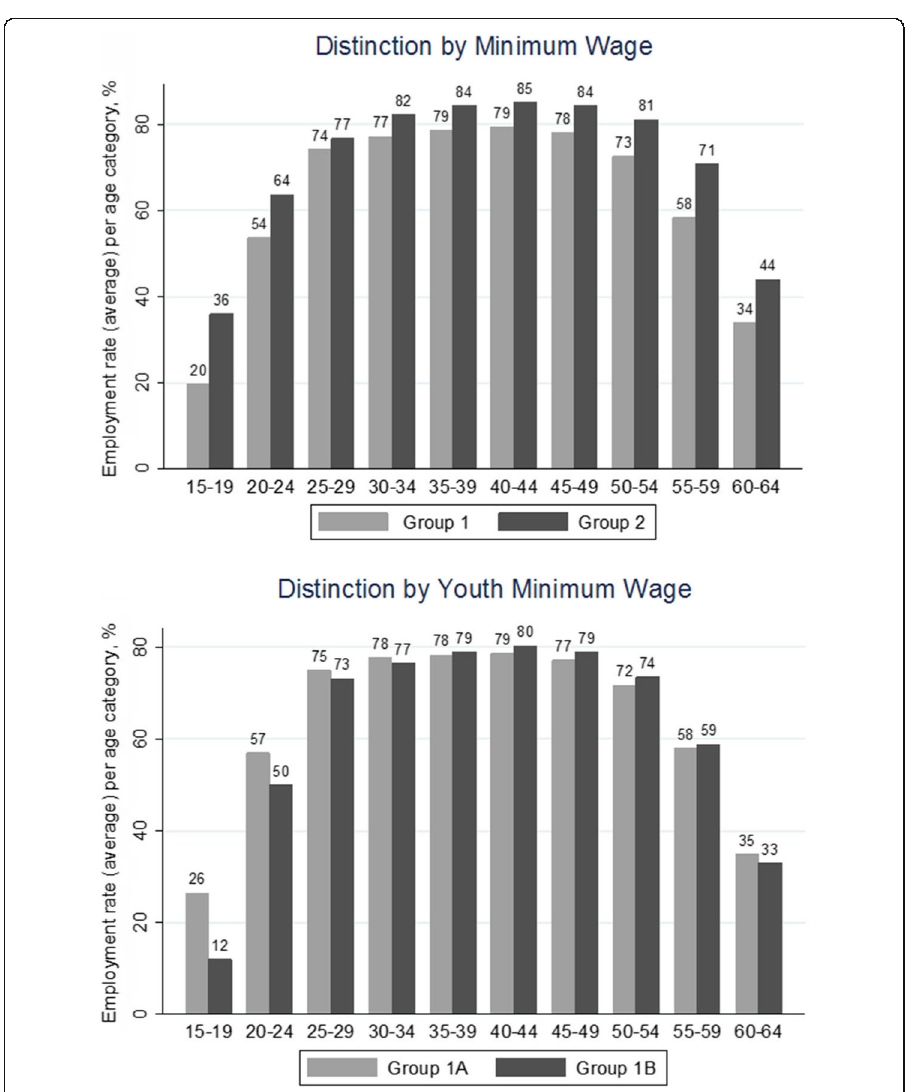
Fig. 3 Average employment rate per age category for countries with statutory minimum wages (group 1) and without statutory minimum wages (group 2) and for countries with youth wages (group 1A) and with uniform wages (group